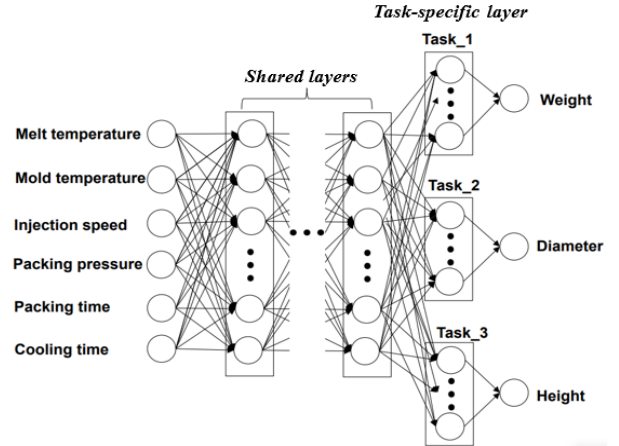
Figure 5. The multi-input multi-output (MIMO) structure using multi-task learning in the present study (hard parameter sharing) [21,22].